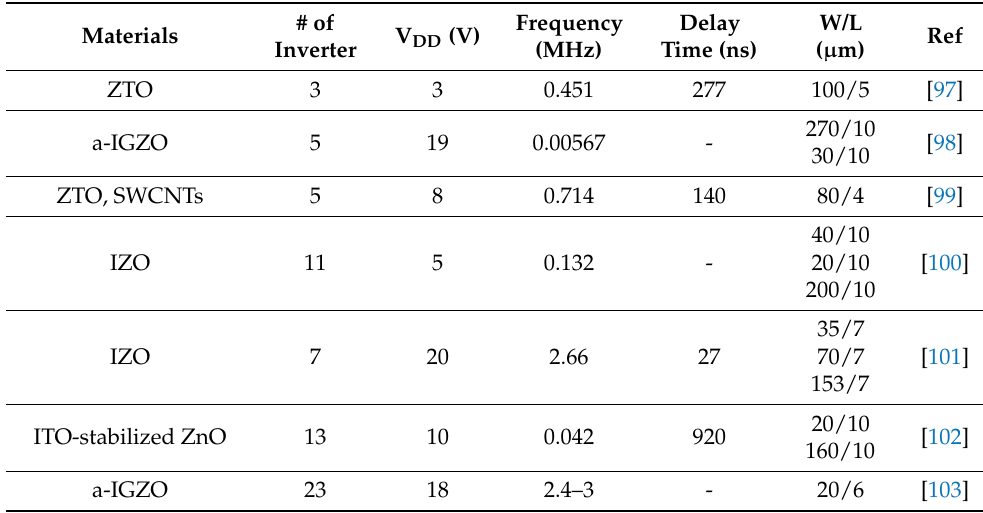
Table 3. Ring oscillator